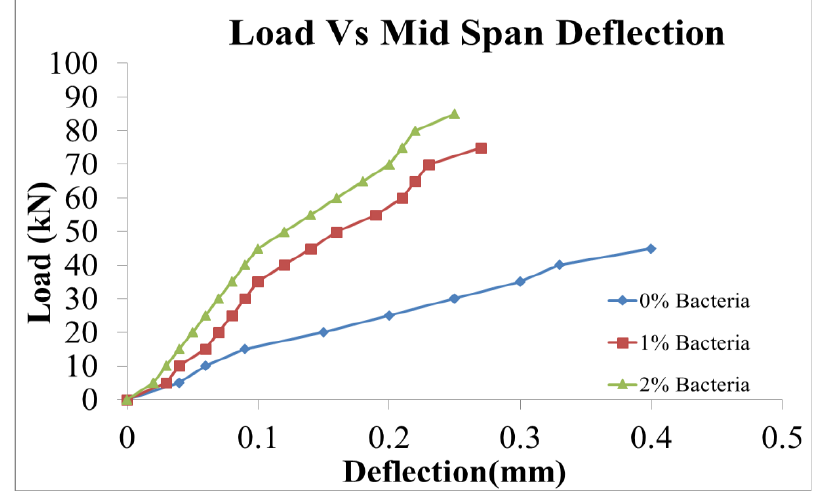
Figure 17. Load – deflection pattern from experiment. Figure 17. Load–deflection pattern from experiment.